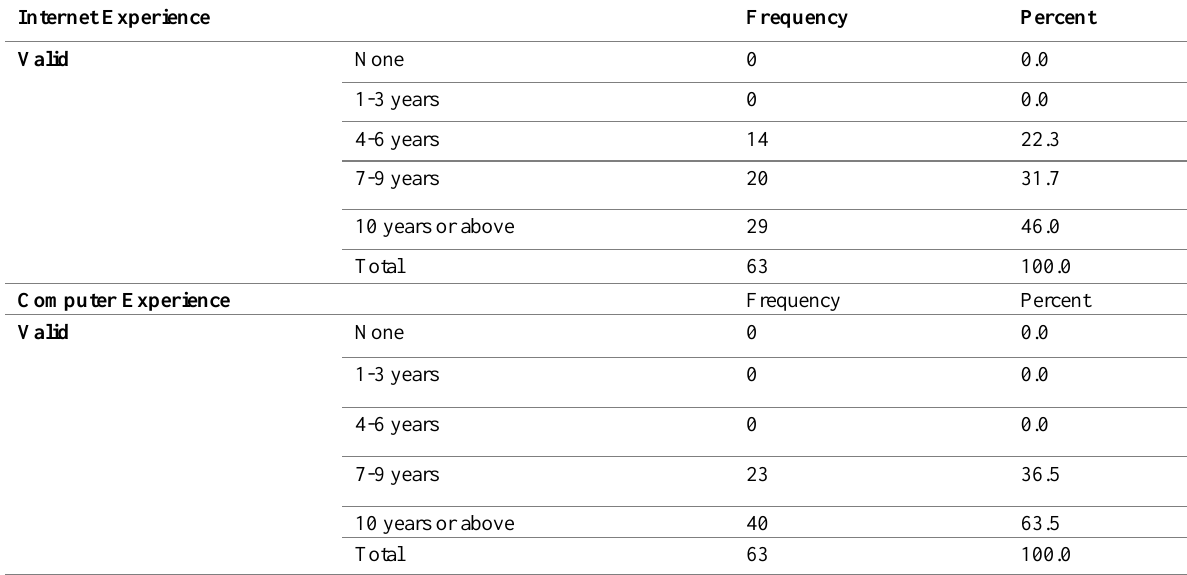
Table 4 : Computer and Internet Experience of The